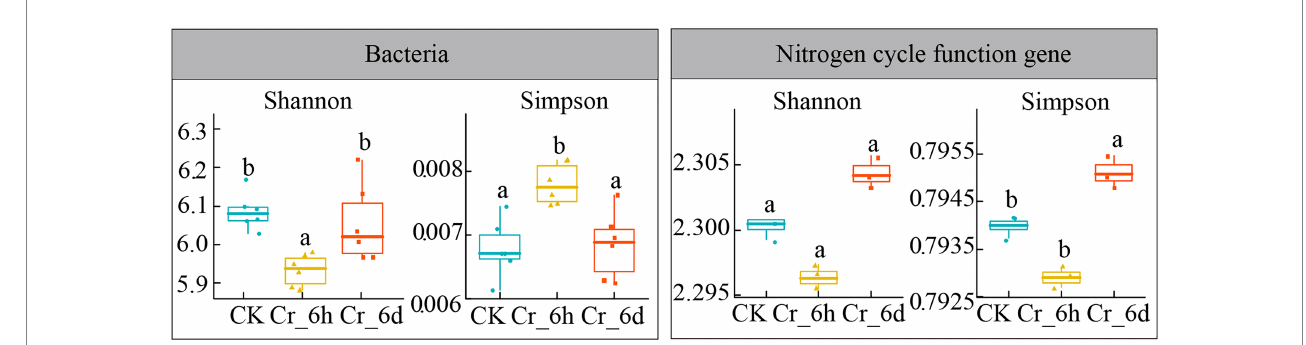
FIGURE 4 Analysis of the bacterial community α -diversity indexes in chromium-contaminated soils. CK, control treatment; Cr_6h, Cr stress for 6 h; Cr_6d, Cr stress for 6 days. Different letters indicate significant differences among treatments at the p < 0.05 level. Dithered points indicate the remaining data points, preventing points of the same value from being hidden. The upper, middle, and lower lines of the box chart represent the upper quartile, median, and lower quartile, respectively, and the vertical line is the error